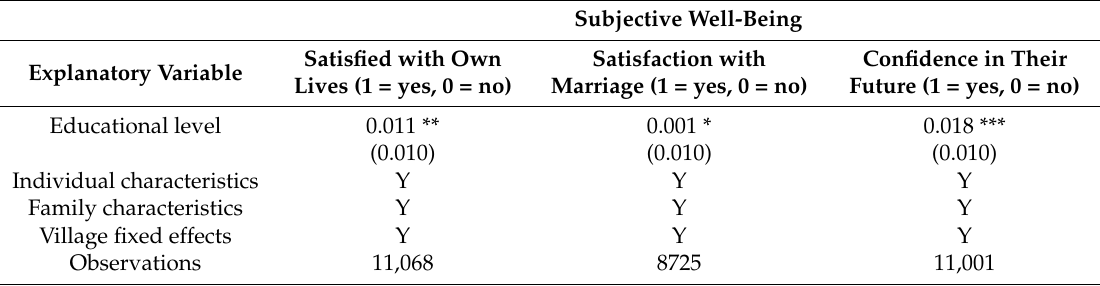
Table 9. The impact of education on subjective well-being